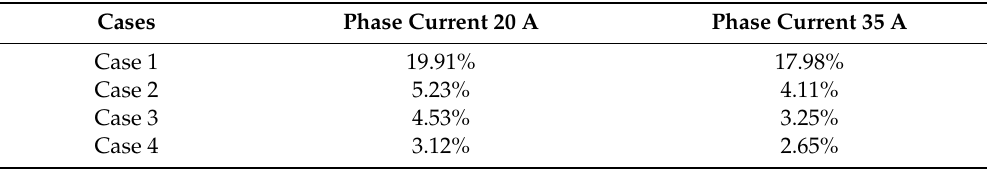
Table 4. Comparison of THDs under 1000 rpm for four di ff erent